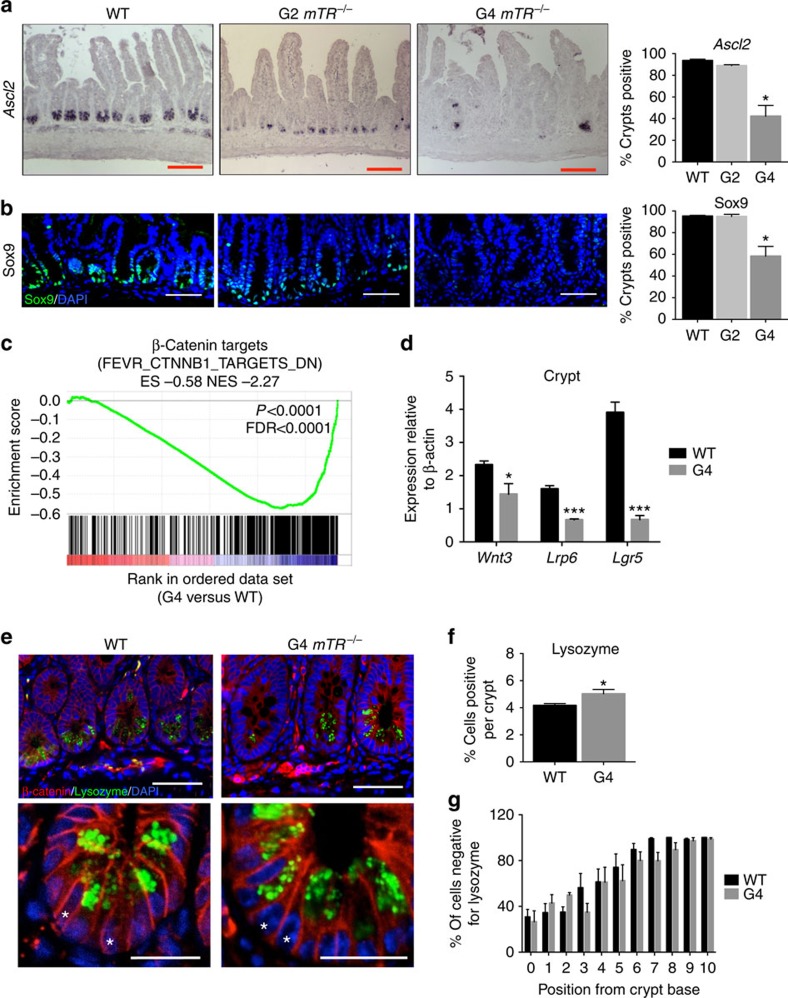
Defects in small intestinal CBC stem cell and Paneth cell gene expression in late-generation mTR−/− mice.(a) Representative images of in situ hybridization for Ascl2 transcripts in ileum from WT, G2 and G4 mTR−/− mice and quantitation of crypts positive for staining (right; n=3); *P<0.05. Scale bars, 100 μm. (b) Representative images of Sox9 immunostaining in ileum from WT (n=5), 2nd generation (G2, n=3) and 4th generation (G4, n=4) mTR−/− mice and quantitation of crypts positive for staining (right); *P<0.05. Scale bars, 50 μm. (c) Gene Set Enrichment Analysis (GSEA) revealed G4 mTR−/− ileal crypts to have significantly reduced expression of genes downregulated in β-catenin knockout mouse crypts (FEVR_CTNNB1_TARGETS_DN) (n=3). Enrichment score (ES), normalized enrichment score (NES), P value and false discovery rate (FDR) are as described50 (see ‘Methods' section). (d) Quantitative reverse transcription PCR (qRT-PCR) analyses of gene expression for the Wnt ligand (Wnt3), Wnt co-receptor (Lrp6) and Wnt target gene and co-receptor (Lgr5) in WT and G4 mTR−/− crypts (n=5). Also, note that Msi1 protein expression is unchanged (Supplementary Fig. 2d). *P<0.05 and ***P<0.005. (e) Immunostaining for Paneth cell lysozyme in WT and G4 mTR−/− ileum. Enlarged insets show examples of cells at the normal CBC location between lysozyme-positive Paneth cells (asterisks). β-catenin staining marks cell peripheries. Scale bars, 50 μm (top), 25 μm (bottom). (f) Quantitation of Paneth cells as measured by lysozyme staining and (g) of cells intercalated between Paneth cells from WT and G4 mTR−/− crypts (n=6); *P<0.05. All error bars reflect s.e.m., and P values reflect unpaired two-tailed Student's t-tests.